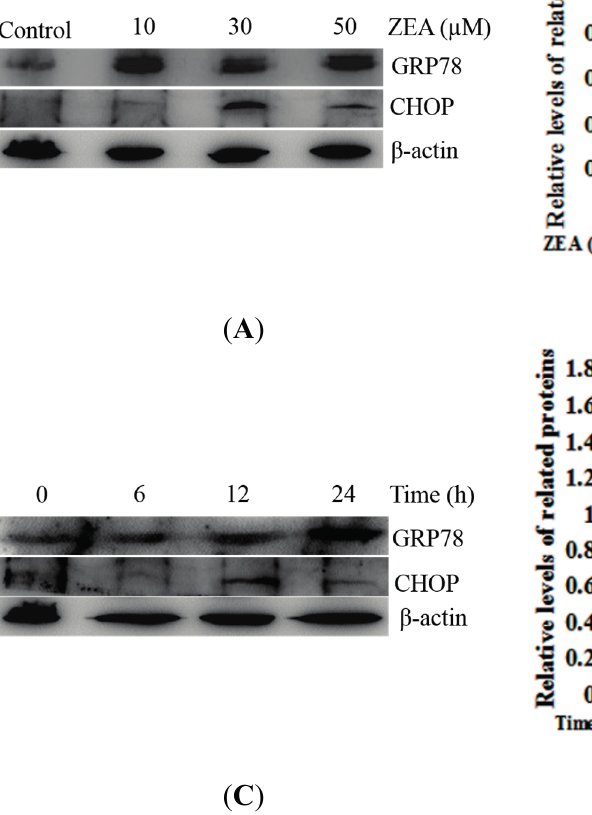
Figure 2. ZEA induces the ER stress-related proteins GRP78 and CHOP in RAW 264.7 macrophages. ( A , B ) The expression of GRP78 and CHOP was analyzed by western blot. Cells were treated with different concentrations of ZEA (control, 10, 30 and 50 µM) for 12 h; ( C , D ) the expression of GRP78 and CHOP was analyzed by western blot. RAW264.7 macrophages were treated for different times (0, 6, 12 and 24 h) with 30 µM ZEA. Analyses of the band intensity on the films are presented as the relative ratio of GRP78 and CHOP to β -actin. Statistical analysis is shown in the bar graphs. Data are presented as the mean ± SEM of three independent experiments. Bars with different letters are significantly different ( p <